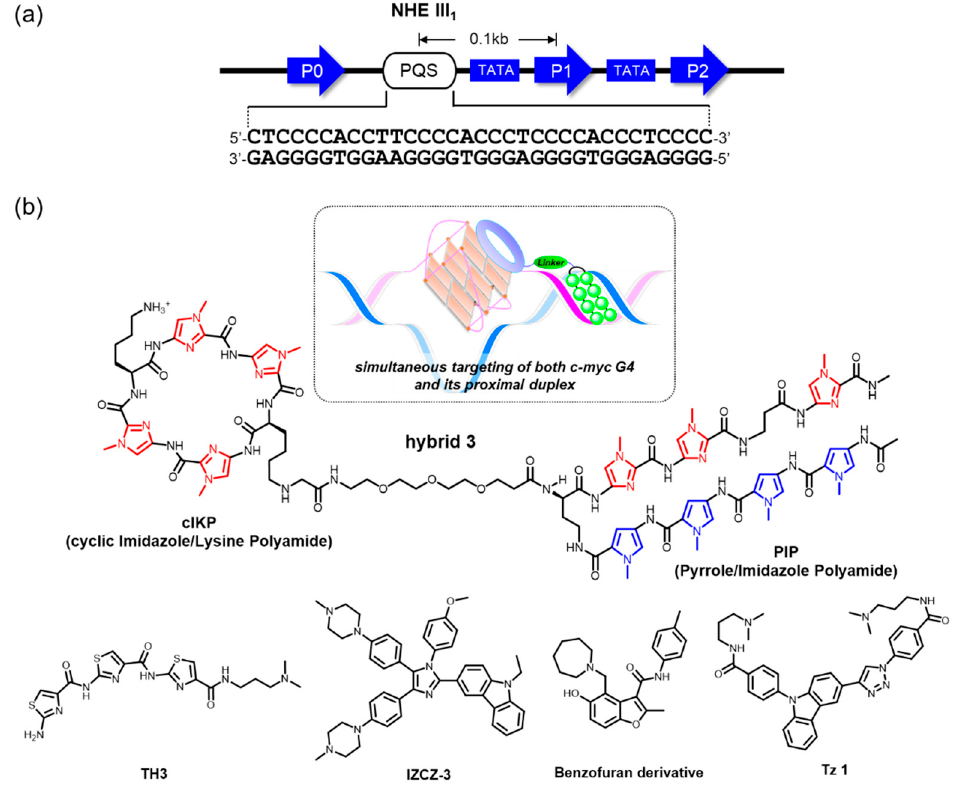
Figure 3. ( a ) The c- MYC promoter has one putative G4-forming sequence (PQS). ( b ) Molecules preferentially interacting with its G4 DNAs over other ones. N -Methylpyrrole is highlighted in blue and N -methylimidazole is highlighted in red. Antitumor activities of TH3, IZCZ-3, benzofuran derivative, and Tz 1 are summarized in Table 1.